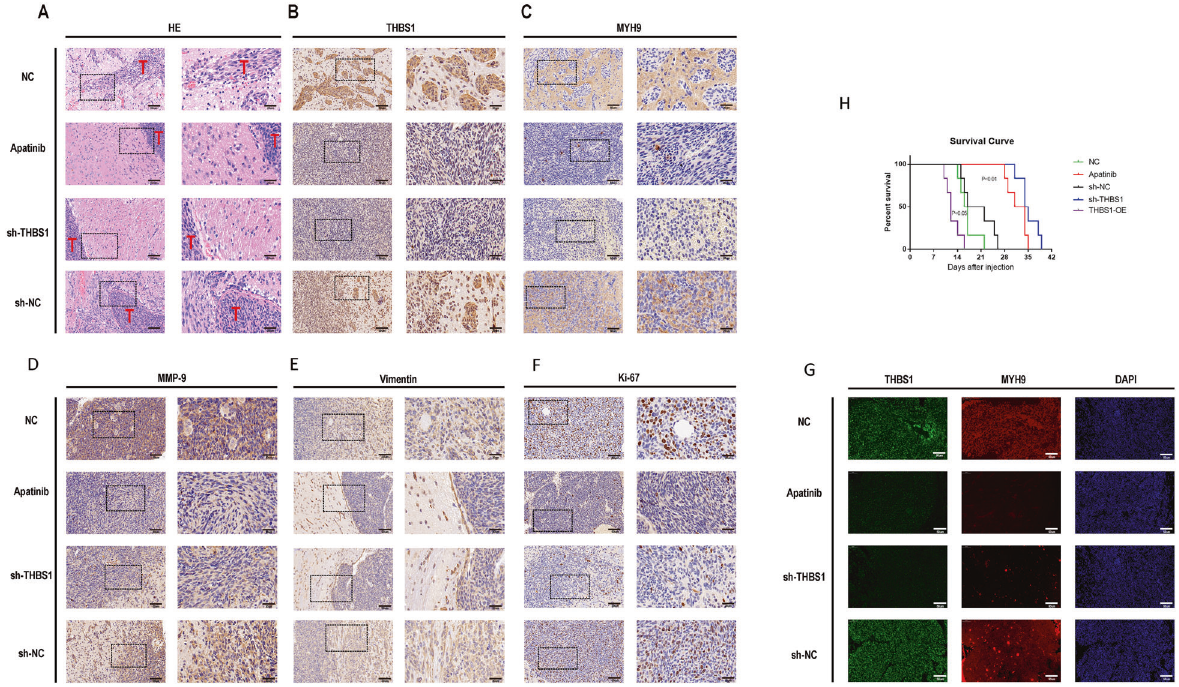
Fig. 8 Apatinib inhibited the proliferation and invasion of glioma cells through the THBS1/MYH9 axis in vivo. Representative four groups (apatinib, normal control [NC], shTHBS1, and negative virus control [sh-NC]) in A hematoxylin and eosin (H&E) staining and immunohistochemistry (IHC) staining images of B THBS1, C MYH9, D Ki-67, E matrix metalloprotease 9 (MMP-9), and F vimentin of tumor sections. G Immuno fl uorescence images of mouse brain tumor tissue showed the same results as the IHC images of THBS1 and MYH9. H Survival analysis showing the overall survival (OS) of mice in the THBS1-OE, apatinib, NC, shTHBS1, and sh-NC groups. Data are shown as the mean ± standard deviation (SD), n = 8; ** p < 0.01 compared with the control, analysis of variance (ANOVA)